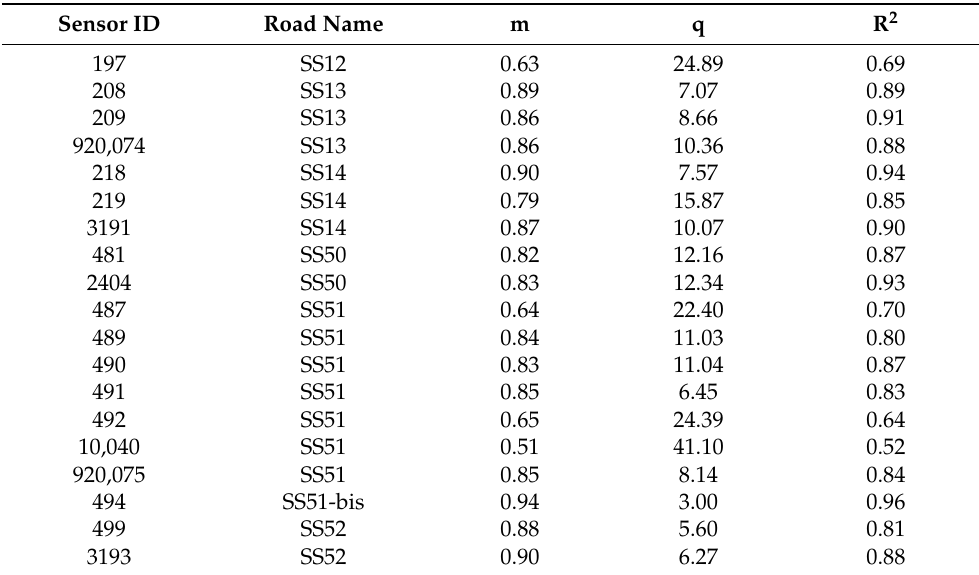
Table A3. Comparison between HCD and sensors speeds through angular coefficients m, and intercepts q of the regression lines, and coefficient of determination R 2 in Dir